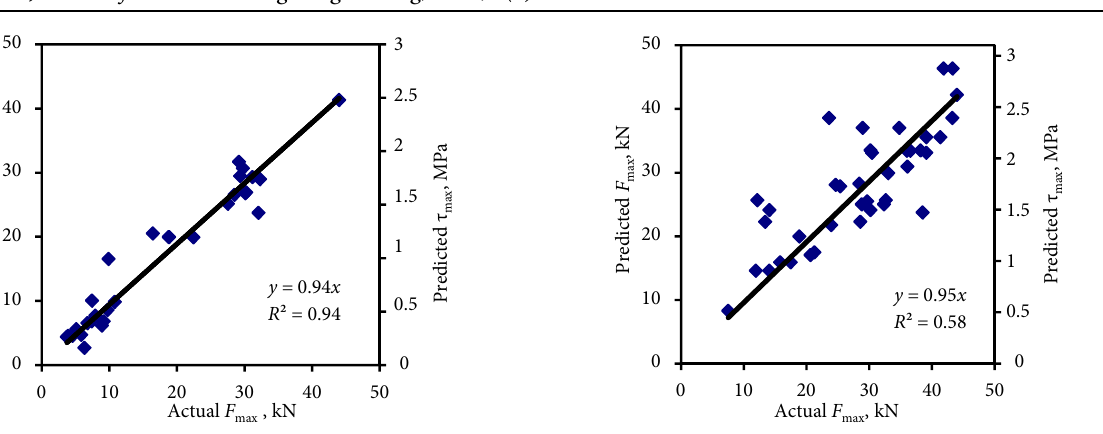
Fig. 7. Prediction of F max for independent query test dataset